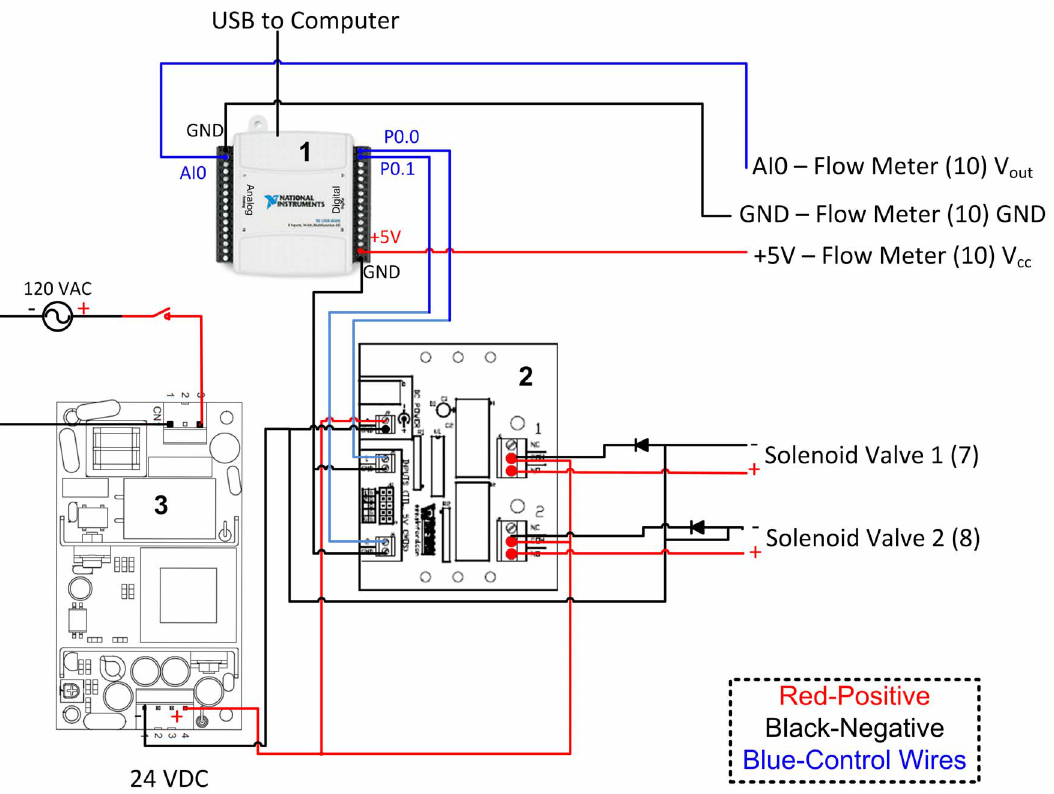
Figure 1. Electronic subsystem schematic. Red lines indicate positive voltage supply ( + ), black lines indicate negative ( 2 ), and blue lines indicate control (digital TTL or analog 0–5 V). Component images for the USB interface (1), relay board (2), and 24 VDC power supply (3), are taken from National Instruments [28], CUI [29], and Winford Engineering [30], respectively. doi:10.1371/journal.pone.0095823.g001 balloon catheter inflation reproducibility. Data was tabulated from both unpublished and published [23–26] results from our group.